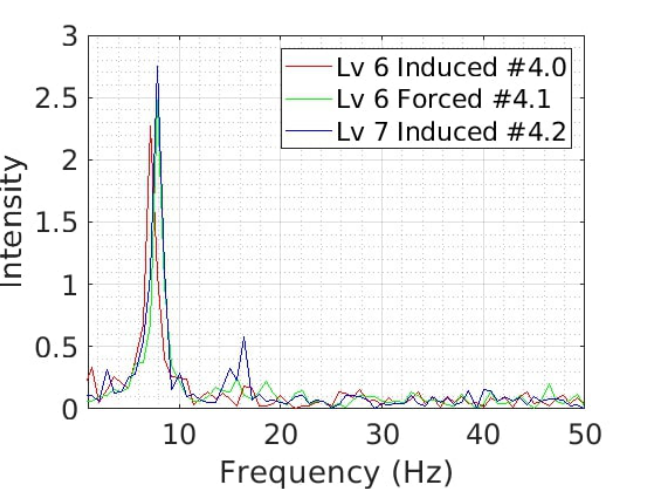
Figure 31. Frequency-based spectra of vorticity for the cases #4.0 (red line), #4.1 (green line) and #4.2 (blue line).